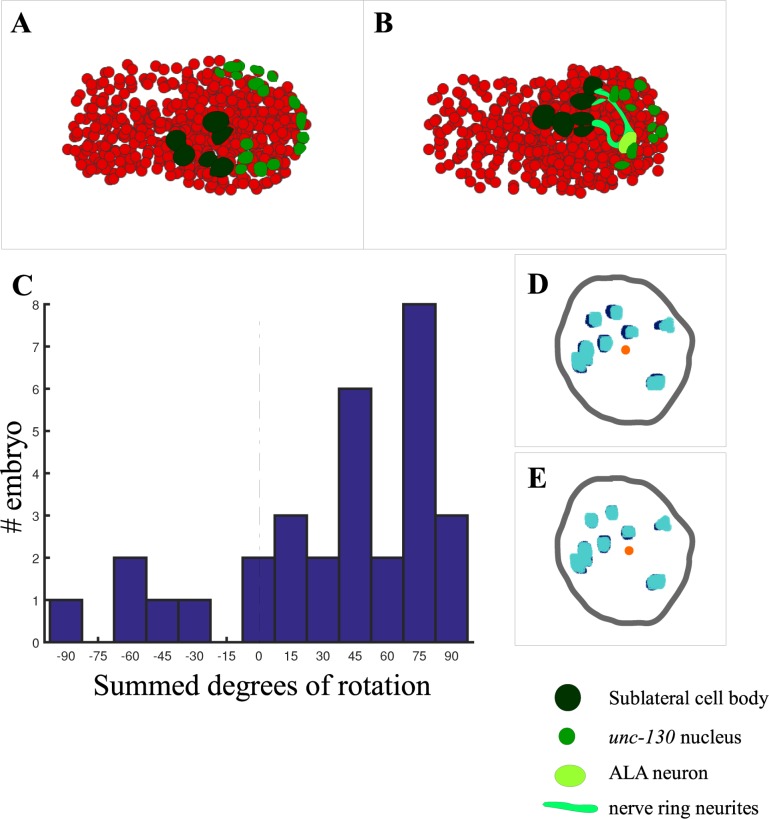
Correcting internal embryo rotations.Internal coordinate systems are established for individual embryos by correcting rotations about the AP-axis throughout development, by point-matching segmented nuclei against one another between time points. A,B) Segmentation of an embryo before (A) and after (B) an internal rotation (and concurrent neurite outgrowth). C) Summed degrees of internal rotations, calculated using the rotation correction method described in the text, in degrees counterclockwise about the embryo long axis. Each point represents a single embryo. Embryos display a preference for counterclockwise rotation (p = 0.001), but magnitude of rotation varies. D,E) Example of rotational correction between adjacent time points. D,E) Overlay of two unc-130::GFP nuclear segmentation channels (light, dark blue) from successive time points, before (D), and after (E) correction.